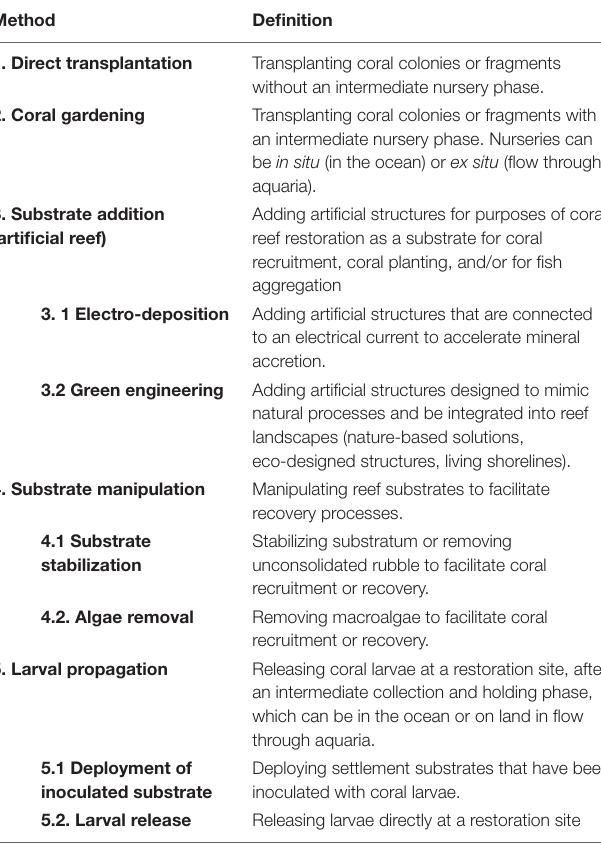
TABLE 1 | Goals and associated rationales of coral reef restoration.